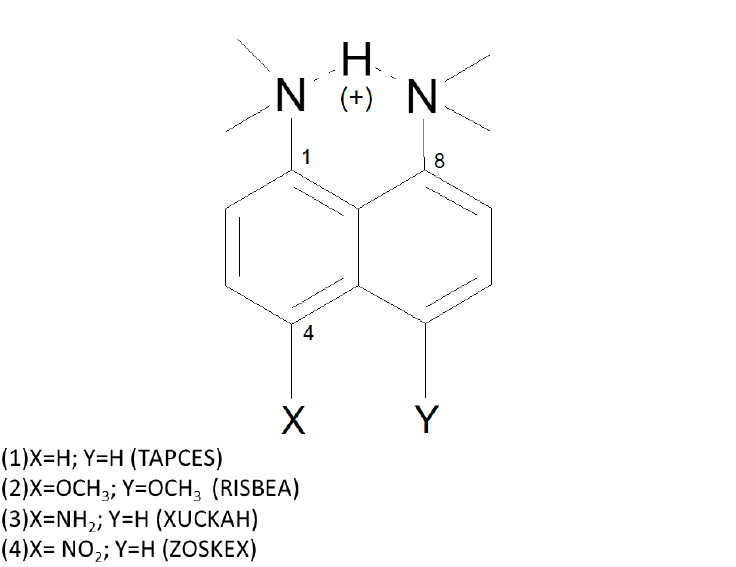
Figure 1. Structure with CCDC code and relevant atoms numbering of the protonated forms of ( 1 ) 1,8-bis(dimethylamino)naphthalene (TAPCES); ( 2 ) 1,8-bis(dimethylamino)-4,5- dimethoxynaphthalene (RISBEA); ( 3 ) 4-amino-1,8-bis(dimethylamino)naphthalene (XUCKAH); ( 4 ) 4-nitro-1,8-bis(dimethylamino)naphthalene (ZOSKEX). The dotted lines indicate the presence of intramolecular hydrogen